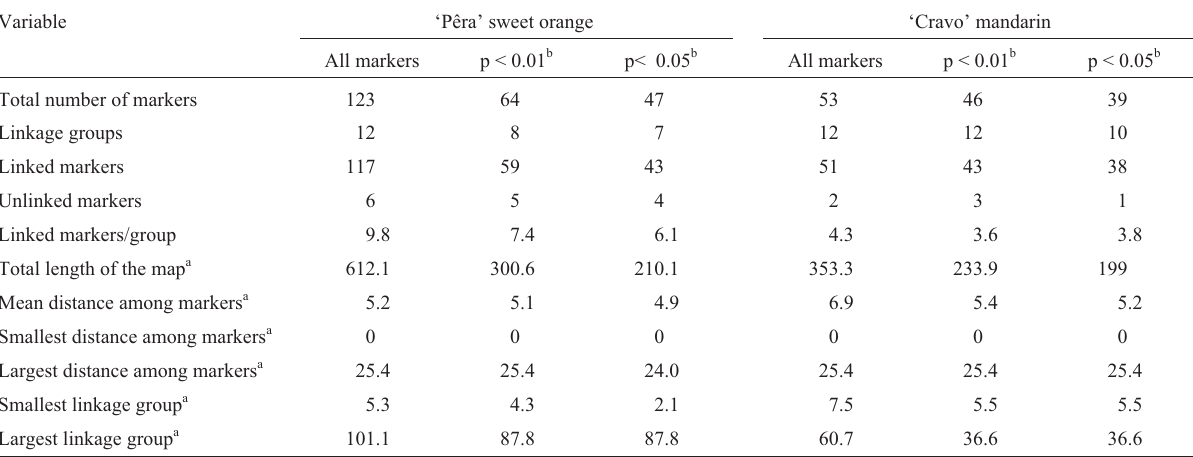
Table 1 - The effect of using RAPD markers with different levels of skewed segregation on the construction of linkage maps for C. sinensis Osb. ‘Pêra’ and C. reticulata Blanco ‘Cravo’. Variable ‘Pêra’ sweet orange ‘Cravo’ mandarin